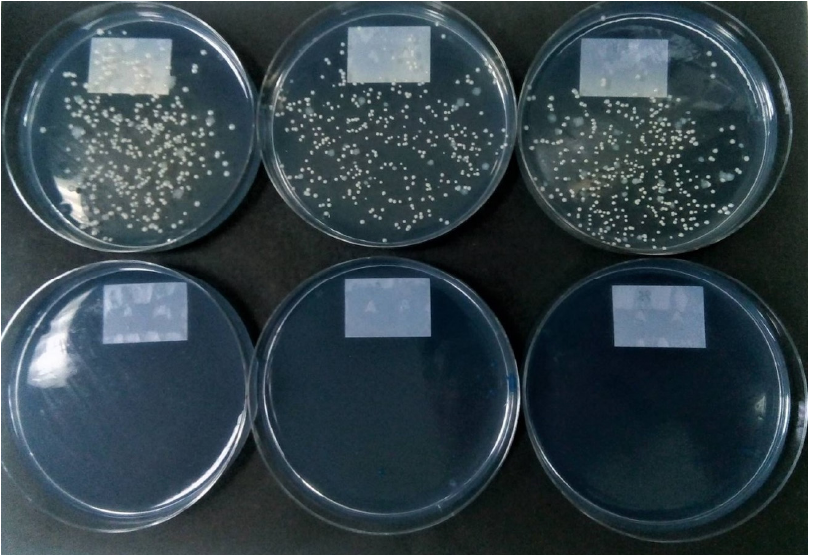
Figure 2. Top row: Replicate cultures of MABSC from sputum showing rough and smooth colony variants recovered by direct inoculation of RGM medium (100 µL of untreated digested sputum per plate). Bottom row: replicate cultures of the same sputum sample on RGM medium showing no colonies following treatment with NALC-NaOH.